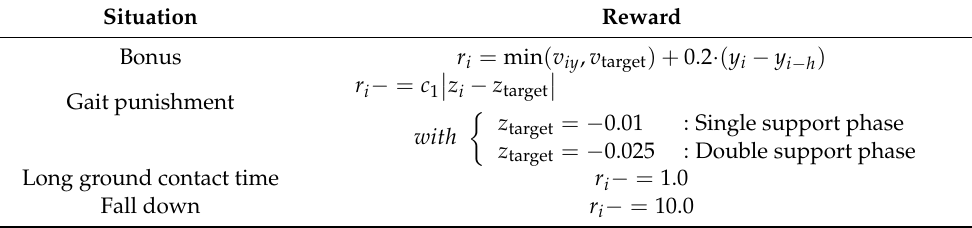
Figure 7. The stage of the bipedal robot’s walk: ( a , b ) are two single phases of walking; ( c , d ) are two double phases of walking. Table 3. Bonus and punishment values at state t of the reward function during robot motion.